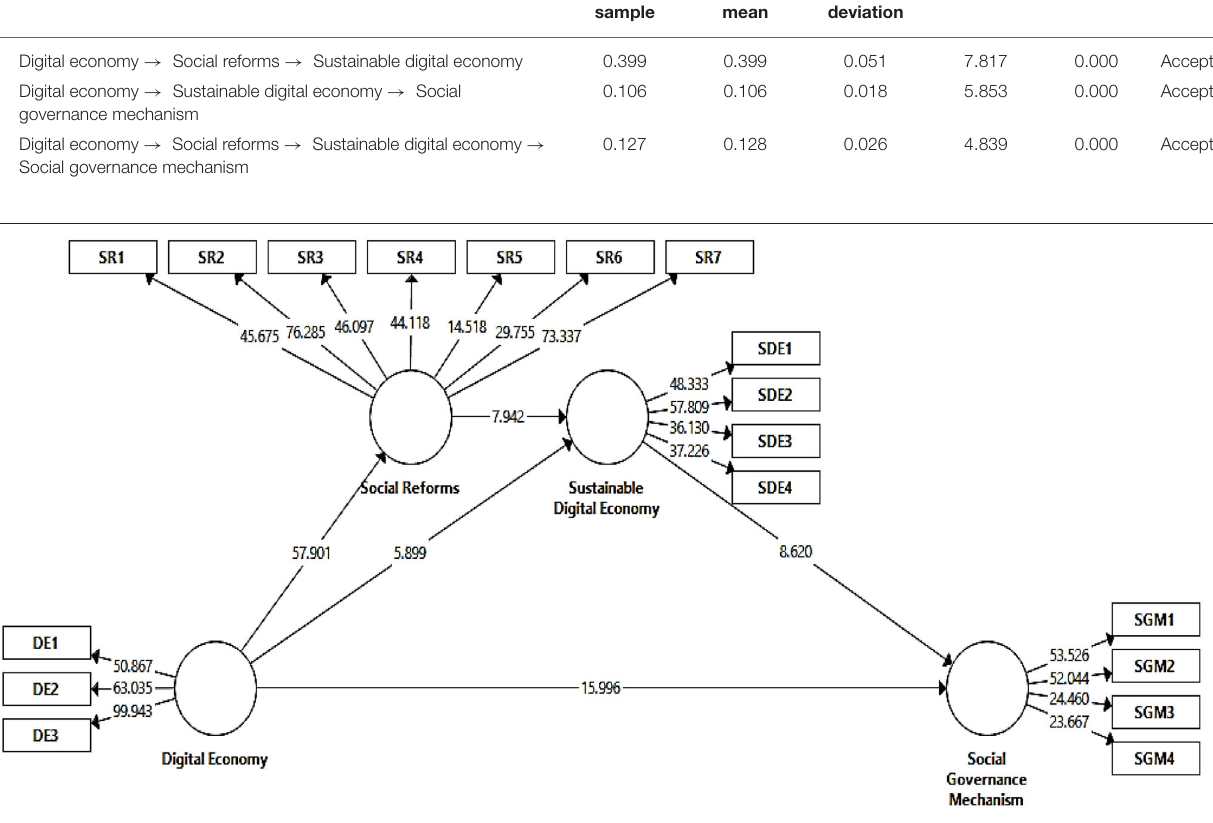
FIGURE 3 | Structural